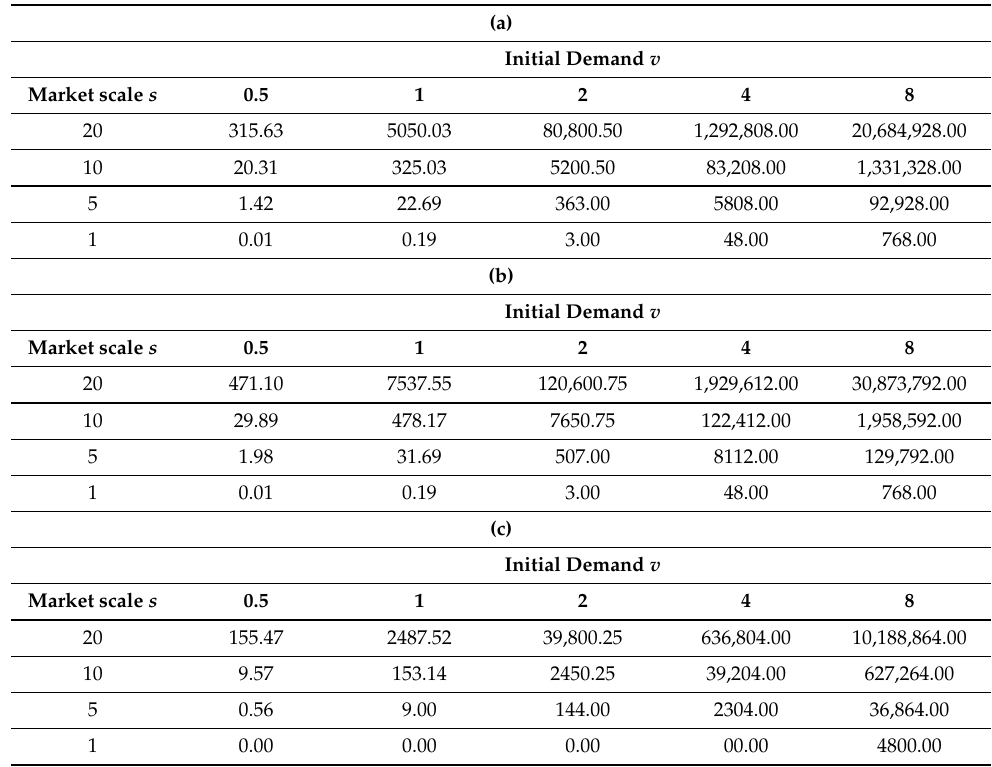
Table 1. The estimated difference of firm values under ICO and STO under moral hazard (values are in millions). ( a ) The firm value under ICO; ( b ) The firm value under STO; ( c ) The difference between firm value under ICO and